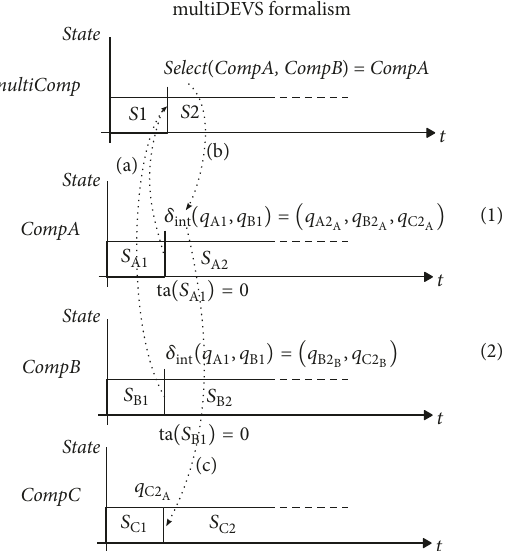
Figure 2: Illustration of state collision serialization using multi-